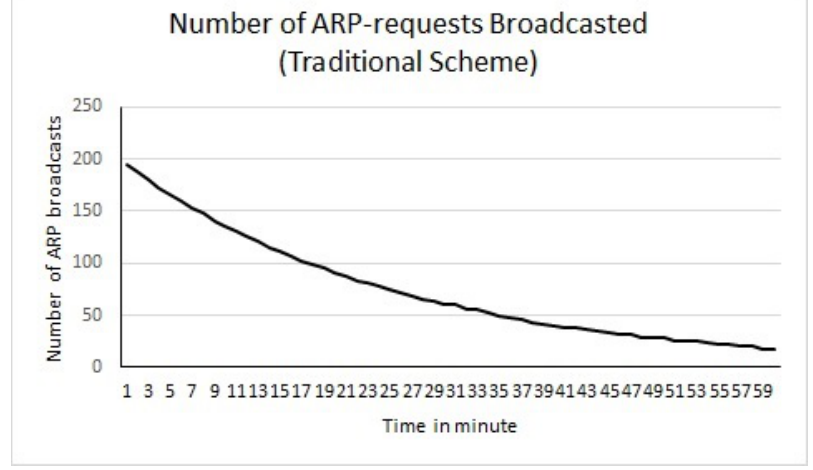
Figure 6. Traditional ARP process with no